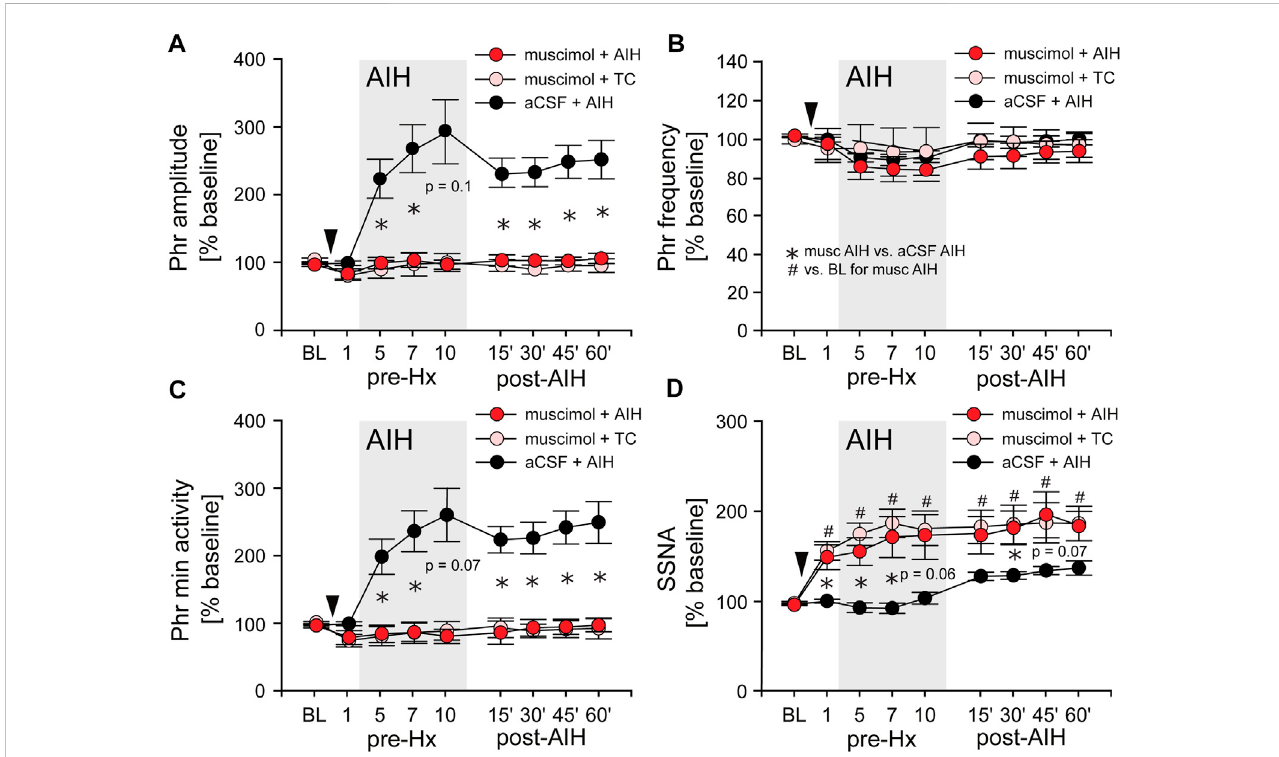
FIGURE 6 Inhibition of nTS neuronal activity prior to AIH prevents the initiation of pLTF. (A) Phr amplitude; (B) Phr frequency; (C) Phr min activity; (D) SSNA (while breathing O 2 enriched air) before (BL, pre-Hx 1), during (pre-Hx 5, 7, 10; grey box) and after (15 ′ , 30 ′ , 45 ′ , 60 ′ ) AIH in animals that received bilateral nTS muscimolinjection(arrowhead)prior toeitherTC(muscimol+ TC;pinkcircles, n=5)orAIH(muscimol+AIH;redcircles, n=8;PhrNA, n=6,SSNA). Datafor animals exposed to AIH without nTS inhibition (aCSF + AIH; black circles, n = 13) prior to AIH are presented for comparison (same data as in Figure 3). Two-way repeated measures ANOVA: p ≤ 0.05; * aCSF + AIH vs. muscimol + AIH, # relative to pre-AIH baseline within a group.